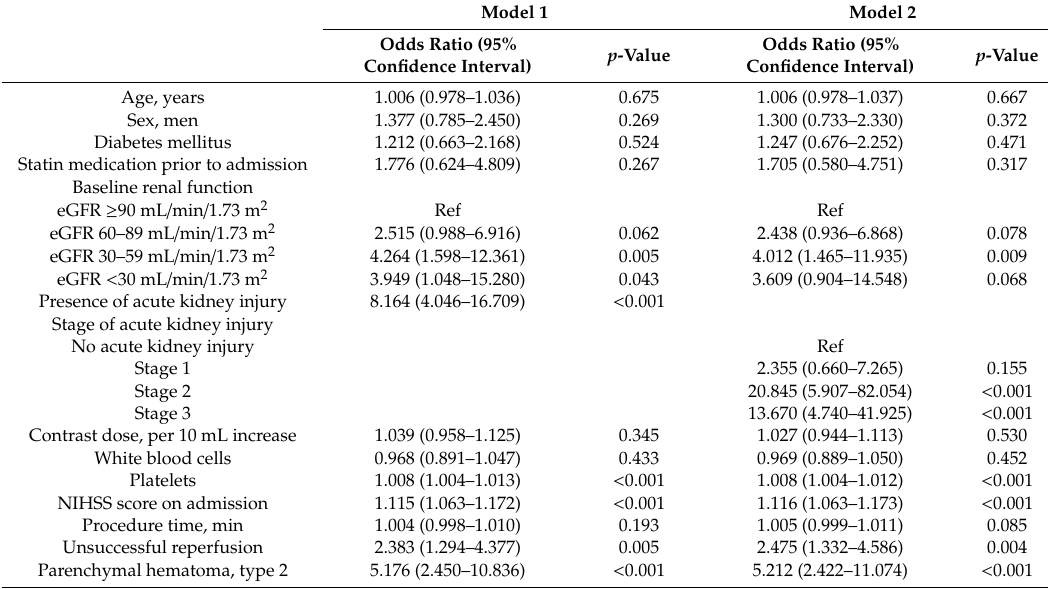
Table 4. Multivariate analysis of factors associated with mortality at 3